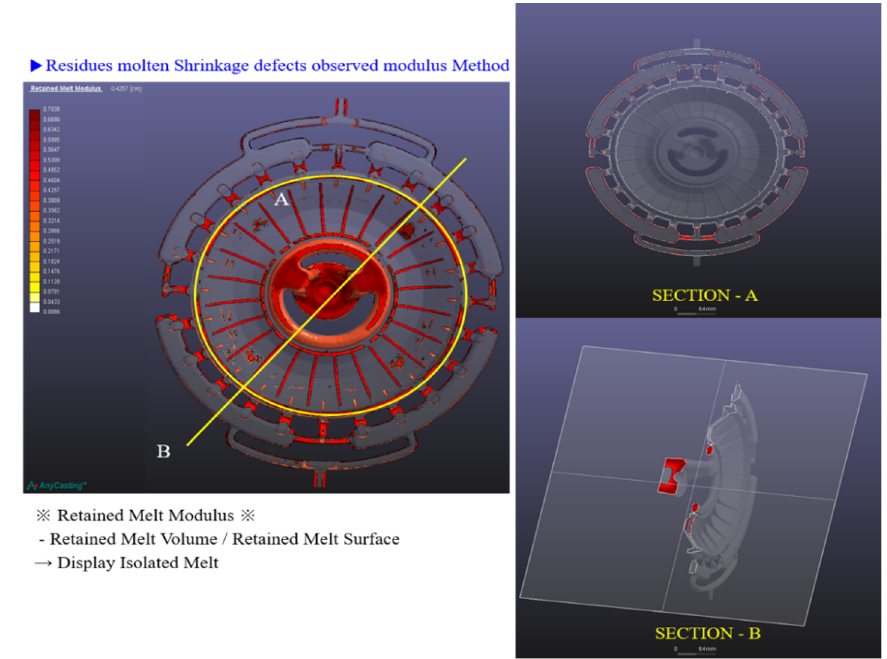
Figure 9. Simulation results of the solidification for case 3.